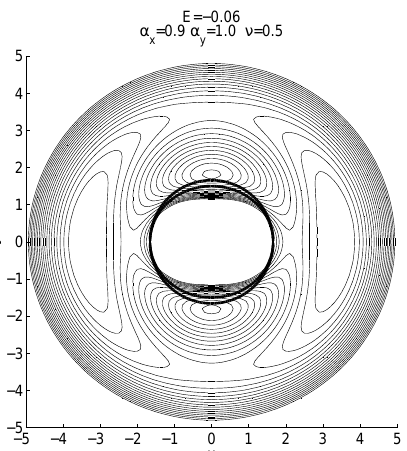
Fig. 1. Zero velocity curves given by the expression K 2 (cid:0) 2 [ E (cid:0) V ( x, y )] [ ] 1 + ν ( x 2 + y 2 ) = 0 where the four equilibrium points can be appreciated for different values of the angular momentum K in the rotating